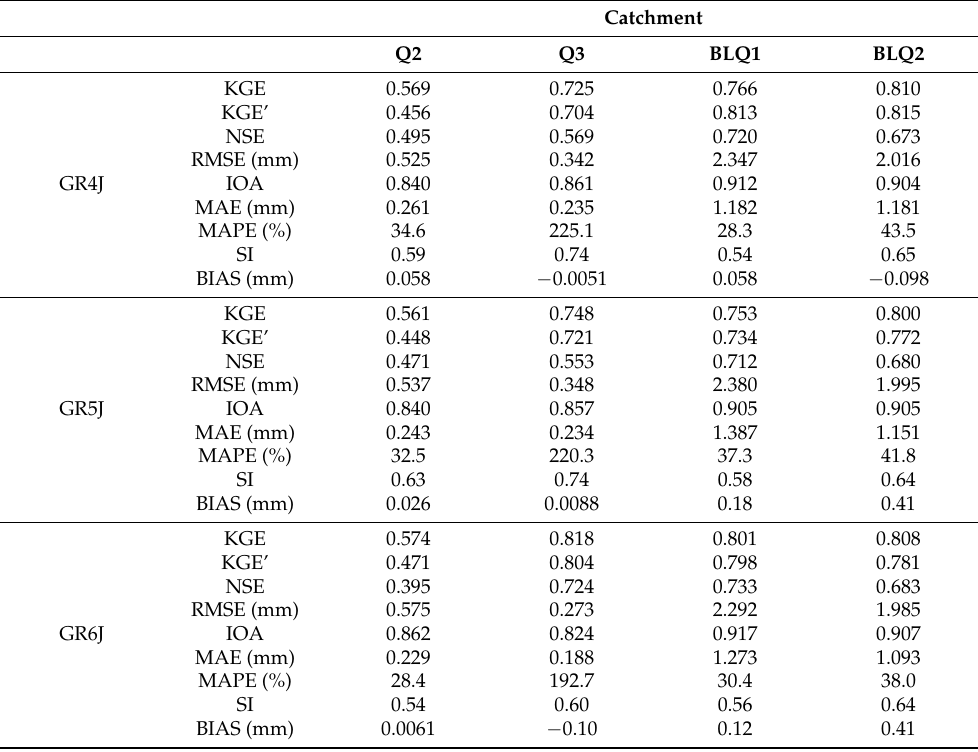
Table 5. Efficiency criteria for the validation period in all basins using the GR4J, GR5J and GR6J hydrological